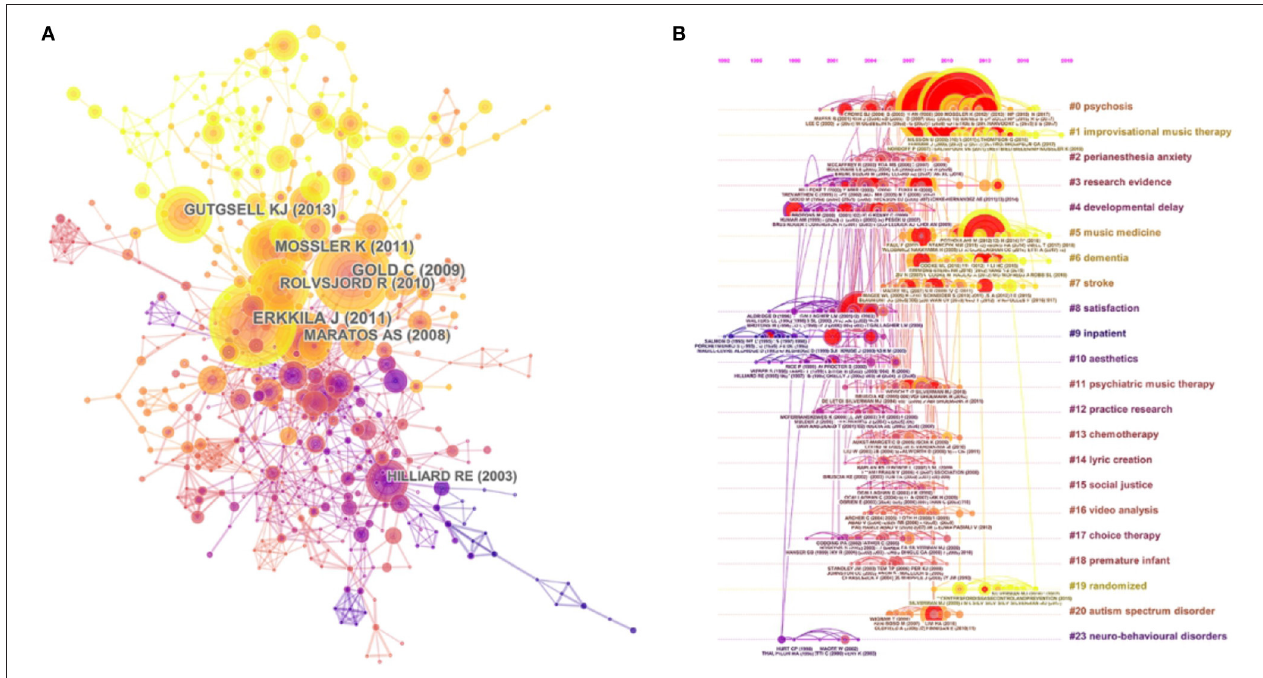
FIGURE 10 | (A) The network map of co-cited references and (B) the map (timeline view) of references with co-citation on top music therapy research. In these maps, the node represents a study, and the link represents the co-citation frequency between two studies. A larger node represents more publications of the author. A thicker purple circle represents greater influence in this field. (A) The nodes in the same color belong to the same cluster. (B) The nodes on the same line belong to the same cluster.